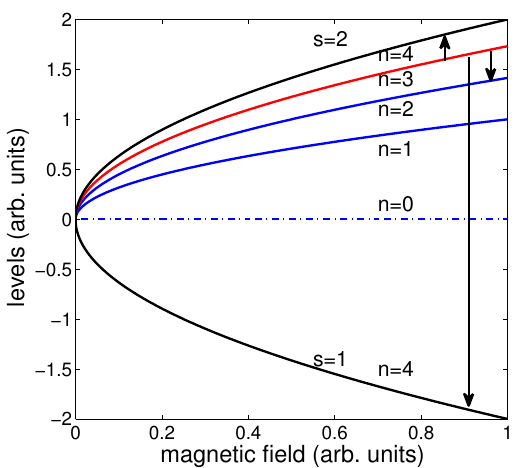
Figure 1. Magnetic levels in graphene and electron transitions involve the level with n = 3 in the conduction band, s = 2